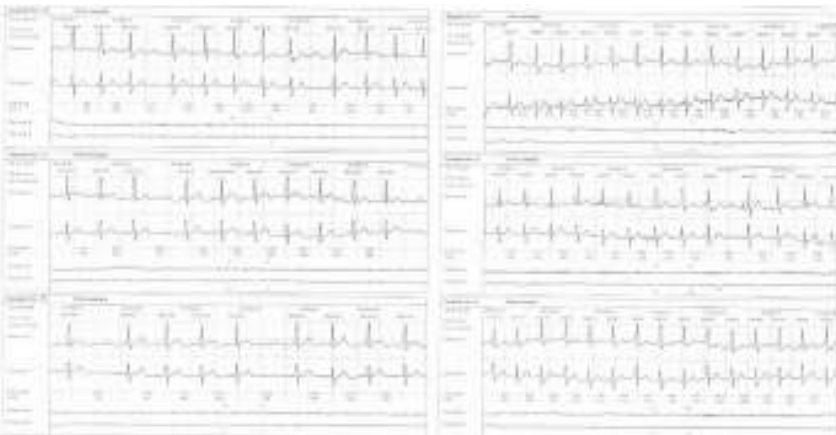
Figure 2 . Holter monitoring results